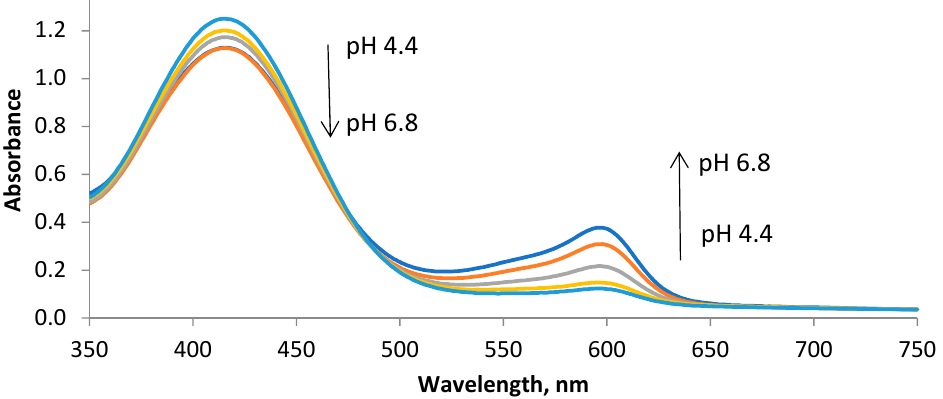
Figure 1. Absorption spectra of SM2-type sensors membranes after contact with milk samples at different pH.